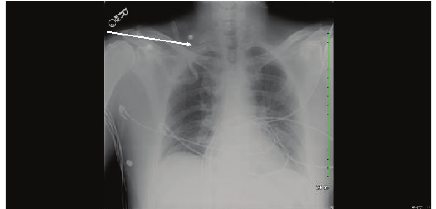
Figure 7: Chest X-ray of our patient after right first rib